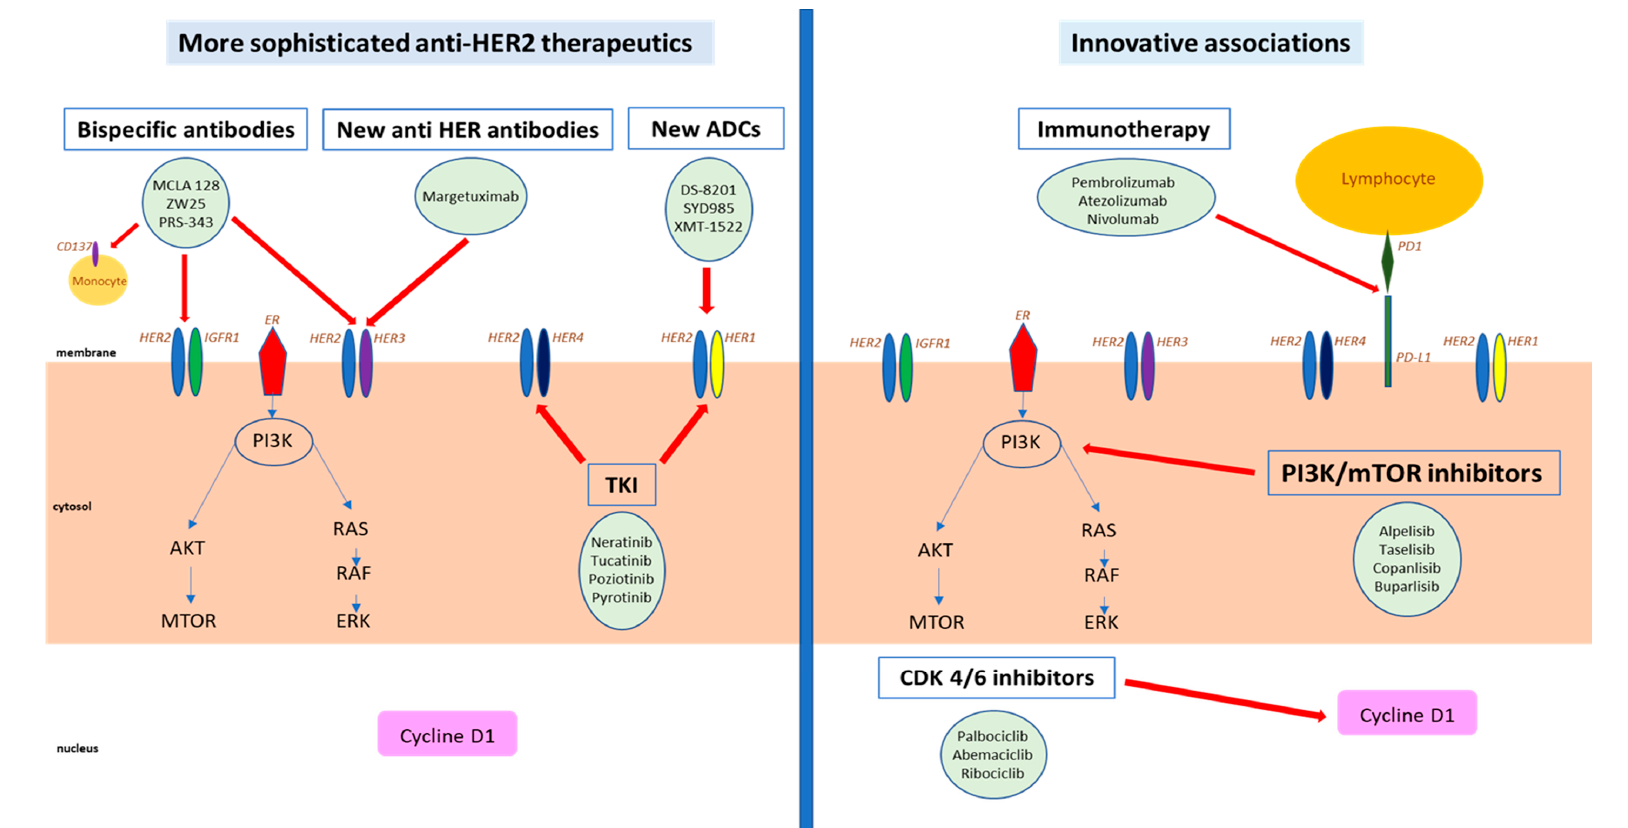
Figure 1. Targets of novel therapeutics in HER2-positive breast cancer.